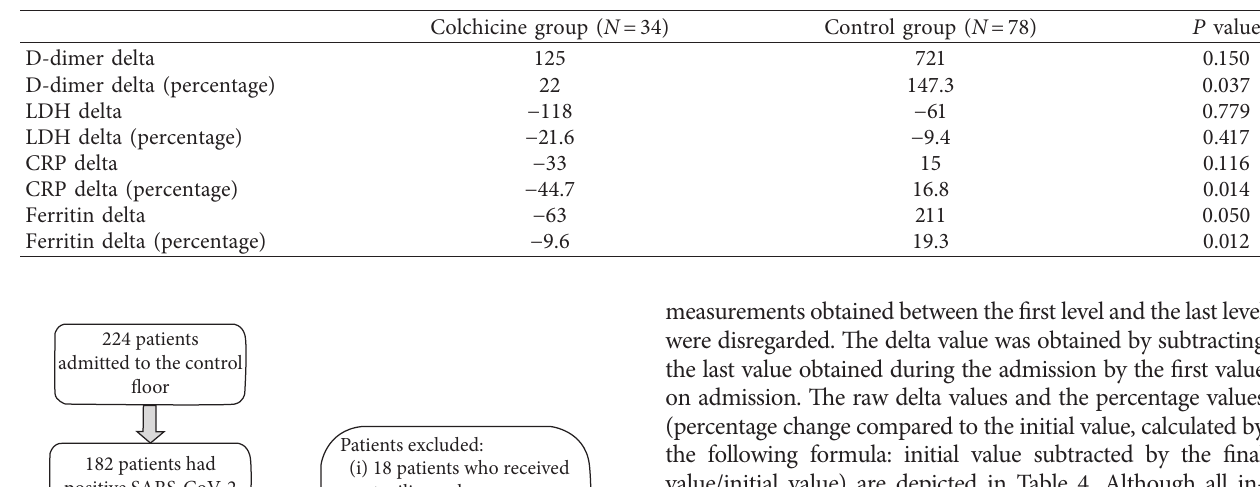
Table 4: Comparison of median values of inflammatory markers delta and delta percentage between the colchicine and control groups. Delta values were calculated by subtracting the last measurement from the first measurement. Inflammatory marker delta and delta percentage was nonnormally distributed; the Mann–Whitney U test was used to check for differences in the two groups.